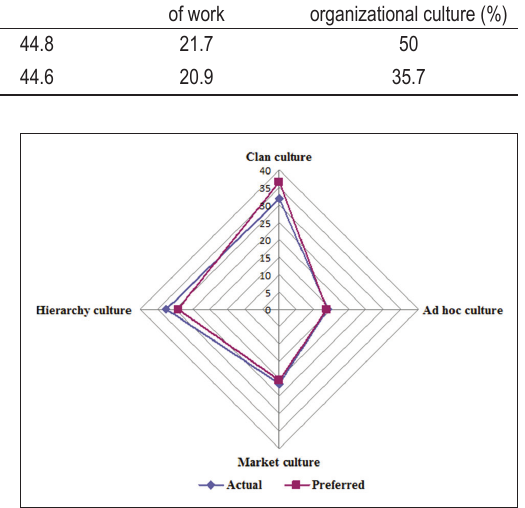
TABLE 1. Health care professionals – respondents, by age, sex and professional structure Health care